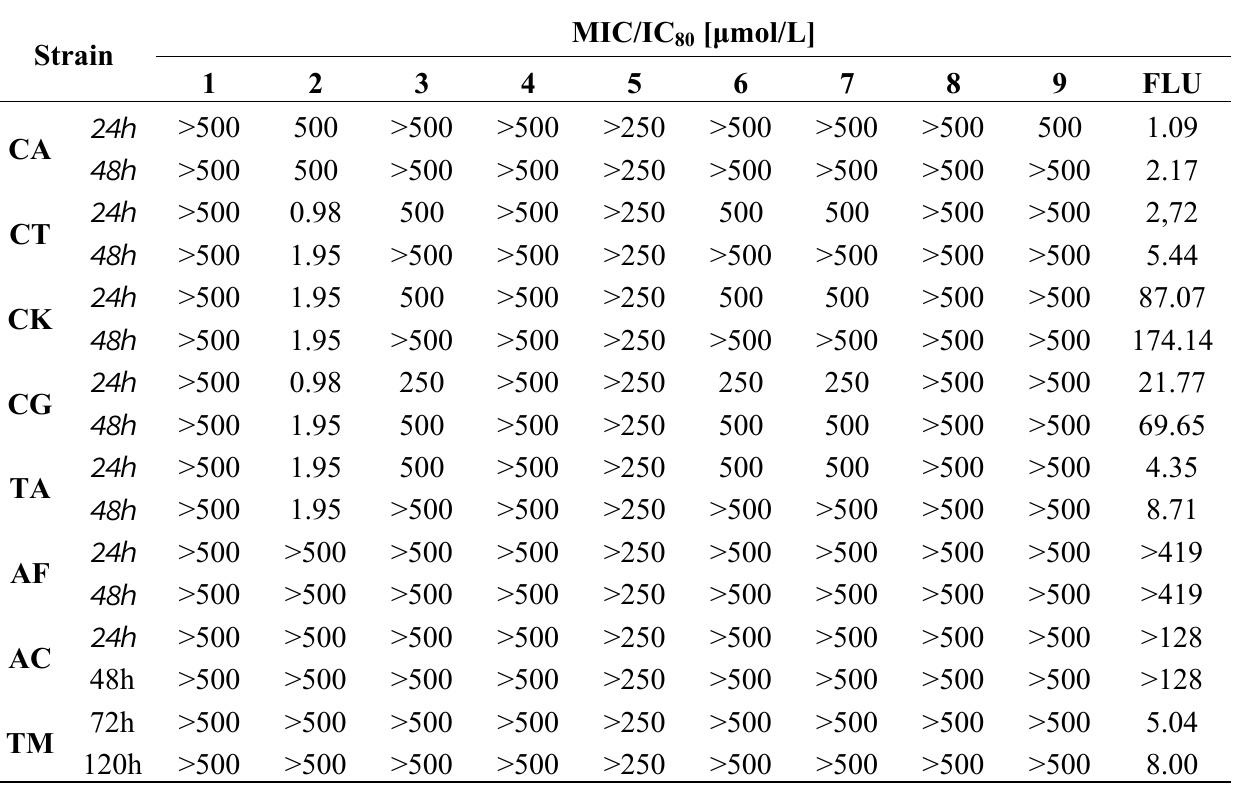
Table 2. In vitro antifungal activity (IC (FLU)